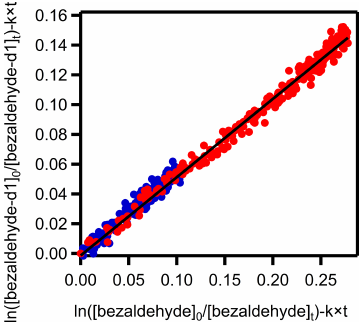
Figure 3. A plot of benzaldehyde PAN (C 6 H 5 C(O)O 2 NO 2 ; BA- PAN) concentrations measured by FTIR as a function of deple- tion of benzaldehyde. The slope of the plot gives a yield of the BAPAN in the NO x -rich environment of roughly 80 ± 22%. Note: the different colors and markers represent repeated experi- ments with different initial NO 2 concentrations. Red filled circles: [NO 2 ] 0 = 1.4–2.9 × 10 12 molec.cm − 3 molec.cm − 3 , blue triangle: